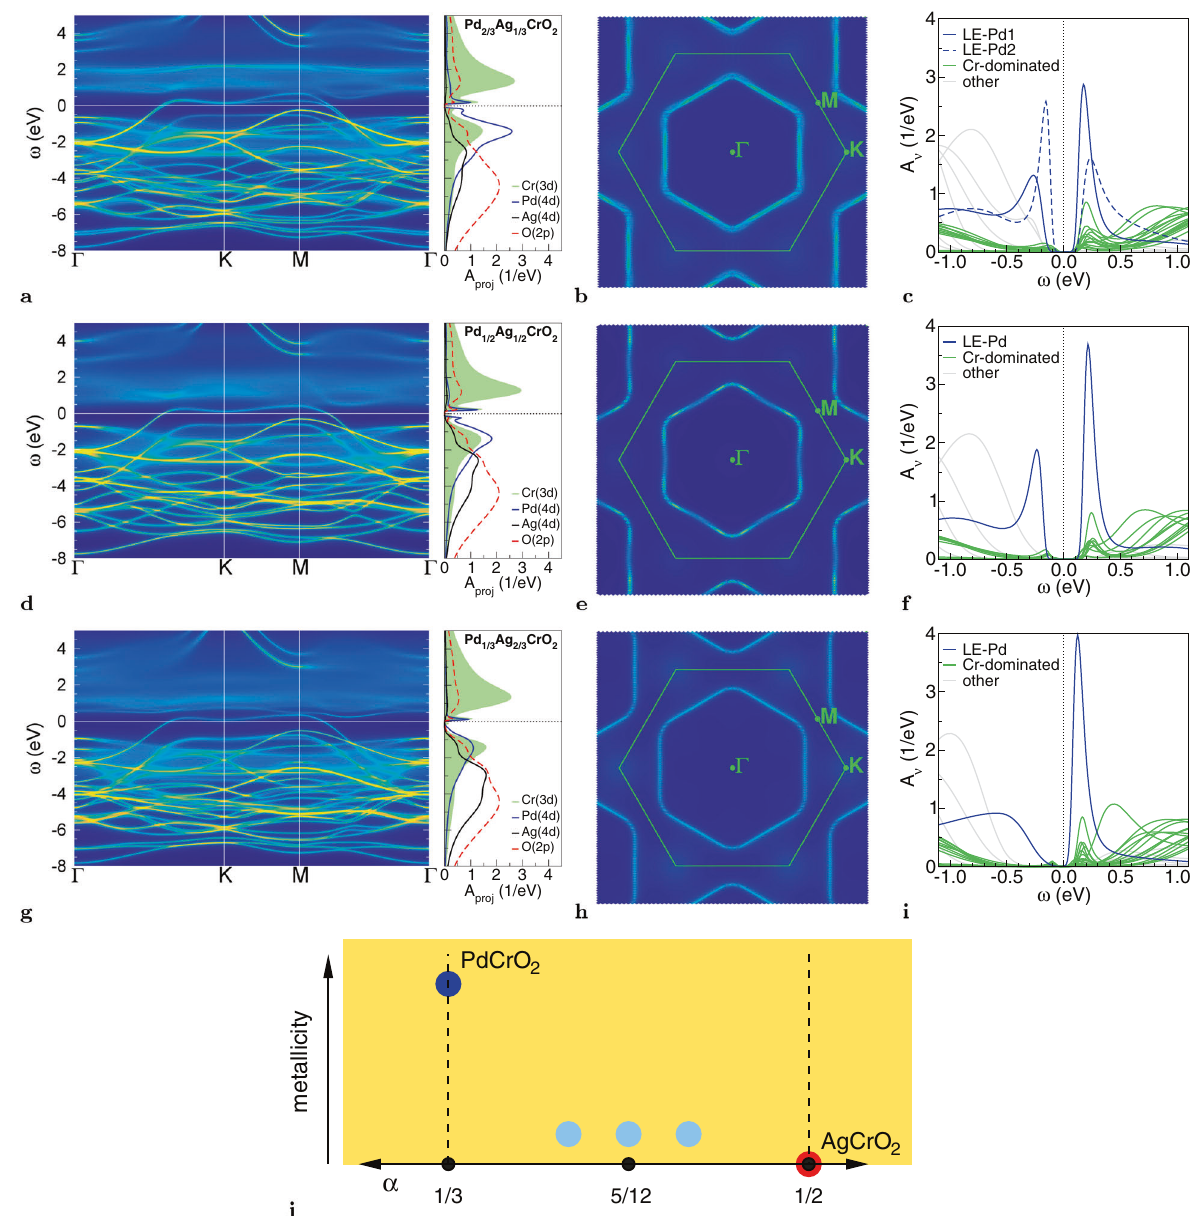
Fig. 8 Paramagnetic DFT + DMFT spectral data for the out-of-plane heterostructures. a – c Pd 2/3 Ag 1/3 CrO 2 , d – f Pd 1/2 Ag 1/2 CrO 2 and g – i Pd 1/ ω ) along high-symmetry lines in the k = 0 plane of reciprocal space (left) and k -integrated site- and z 3 Ag 2/3 CrO 2 . a , d , g Spectral function A ( k , orbital-projected spectral function (right). b , e , h Fermi surface for k z = 0 within the fi rst Brillouin zone (green hexagon). c , f , i k -integrated Bloch contribution A ν ( ω ) with characterization of dominance. From Ref. 72 . j Schematic resulting room-temperature metallicity with respect to the DFT fi lling factor α of the Cr- t 2 g bands. Blue: metal PdCrO 2 , red: band-Mott insulator AgCrO 2 , and lightblue: CIS Pd 2/3 Ag 1/3 CrO 2 , Pd 1/2 Ag 1/ 2 CrO 2 and Pd 1/3 Ag 2/3 CrO 2 (from left to